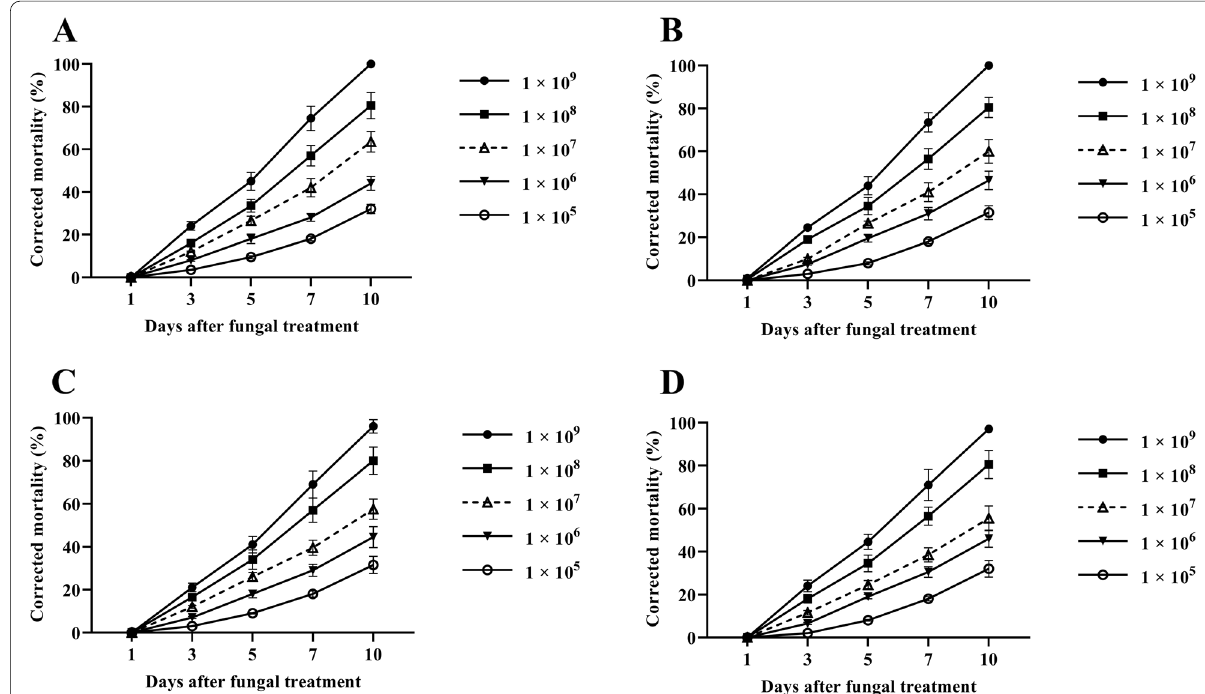
Fig. 2 The effect of conidial concentration and period of time after treatment on the corrected mortalities of M . persicae treated with C . rosea isolate AA80 ( A ) and isolate AA82 ( B ) and A . fabae treated with C . rosea isolate AA80 ( C ) and isolate AA82 ( D